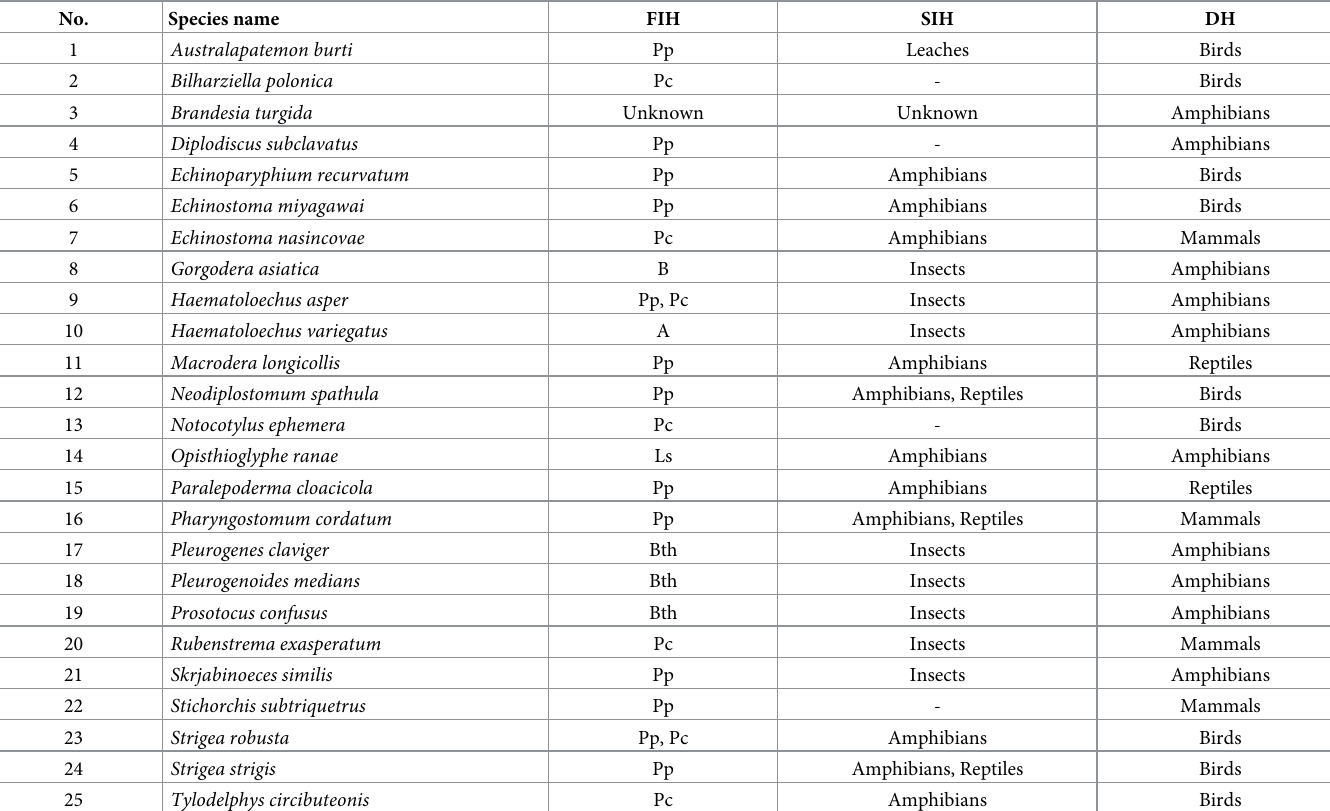
Table 9. Life cycles of trematode species found in Ostrovtsovskaya Lesostep’.